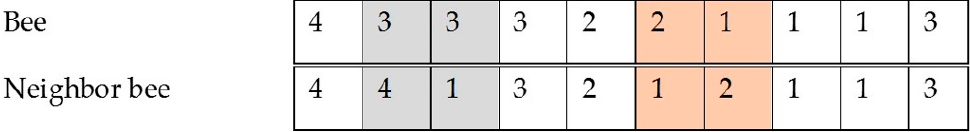
Figure 4. A neighbor bee generated by neighborhood search operator random insertion (RI) (gray) and random swap (RS) (orange).